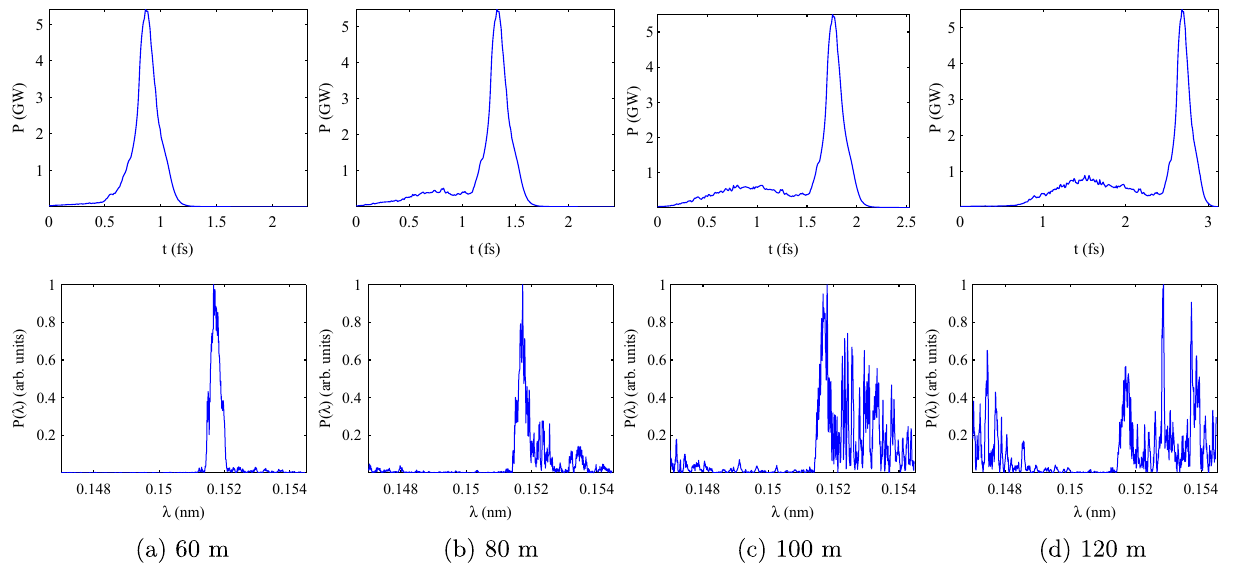
FIG. 8. Simulation results of the FEL pulse (upper) and spectrum (lower) at different locations in the undulator using the electron beam in Fig. 4(b), where the L2 rf phase is − 35 . 0 ° and the undulator is tapered at Δ K=K ¼ − 1% from 20 to 132